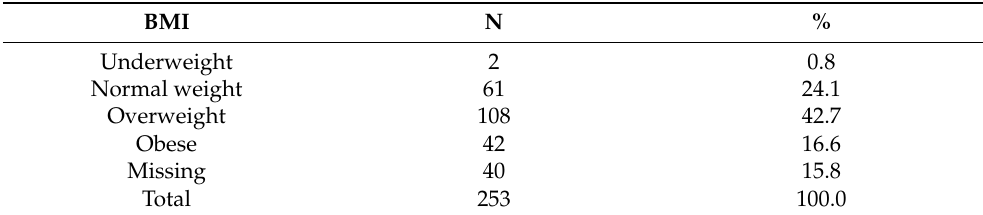
Table 2. Demographic BMI information.